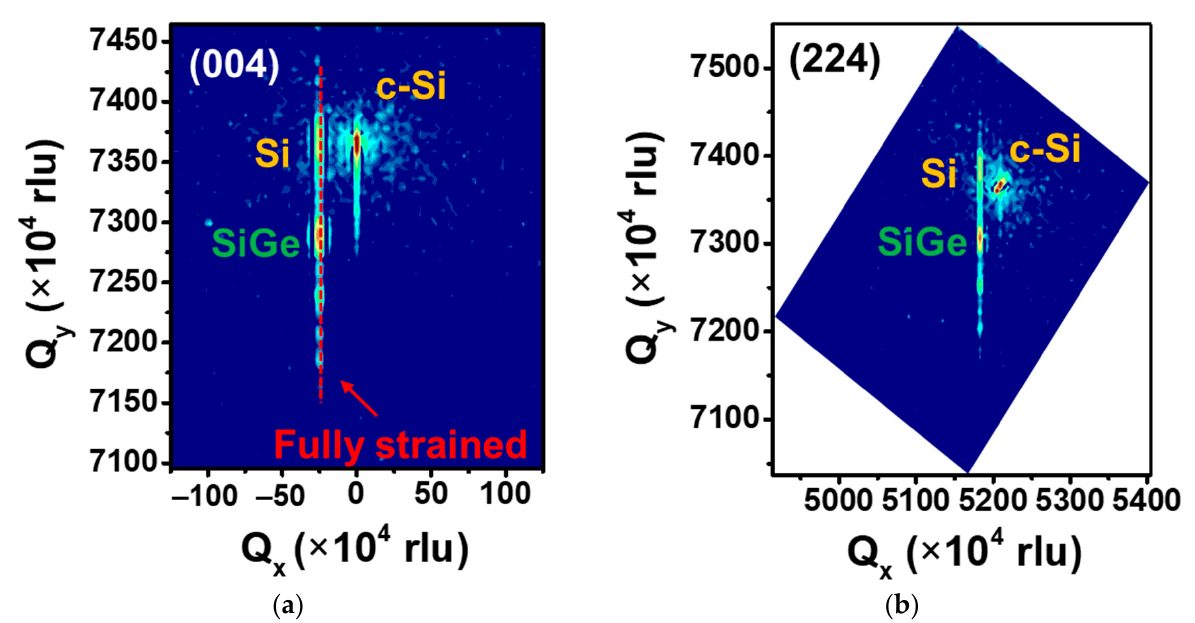
Figure 6. XRD RSM of Si 0.8 Ge 0.2 /Si SL sample in the direction ( a ) (004) and ( b ) (224), showing they are fully strained.